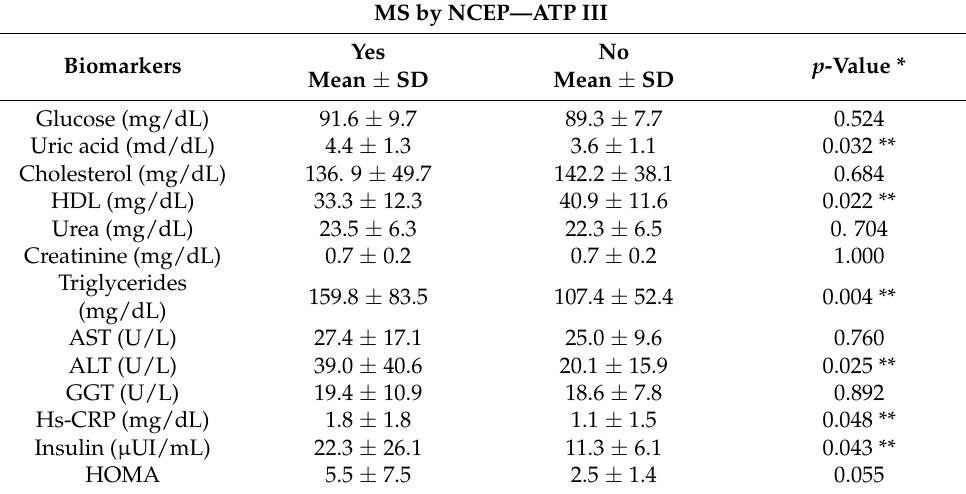
Table 5. Biomarkers and metabolic syndrome in Huatusco, Veracruz, Mexico.